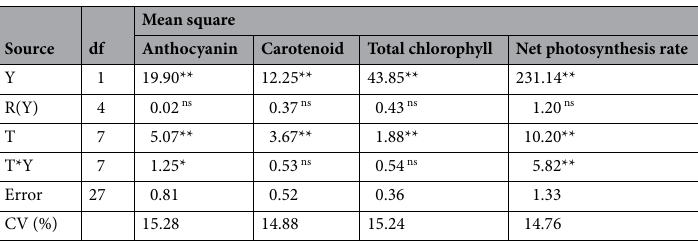
Table 1. Analysis of variance showing the effect of year (Y), treatments (T) (application of plasma, pyroligneous acid, azolla compost and biochar) and interactions (T*Y) of on the biochemical responses